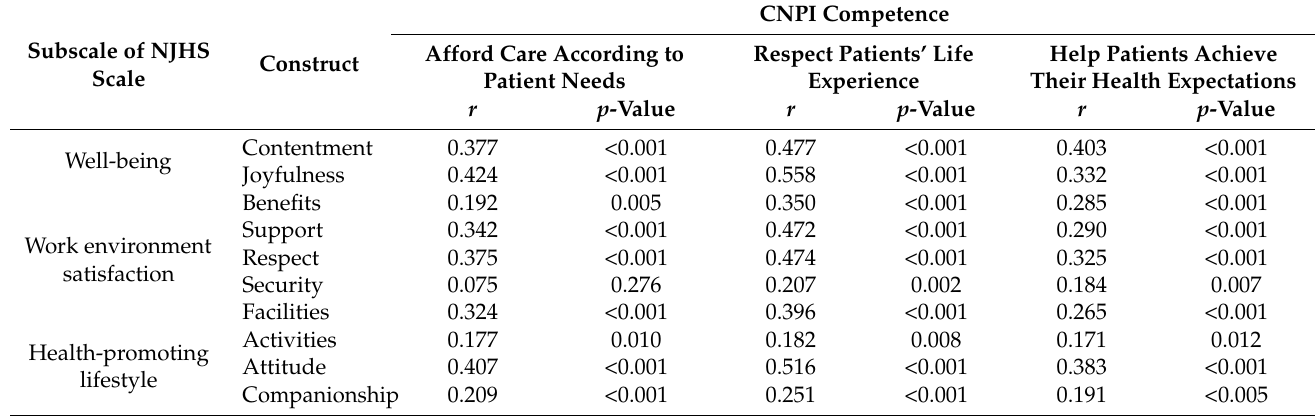
Table 4. Correlation coefficients of the constructs of work environment satisfaction, health-promoting lifestyle, and well-being with CNPI